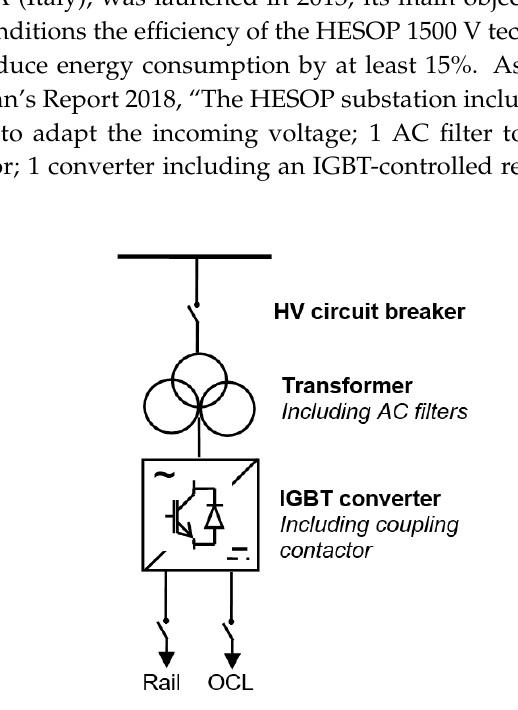
Figure 10. The advanced HESOP architecture [92].